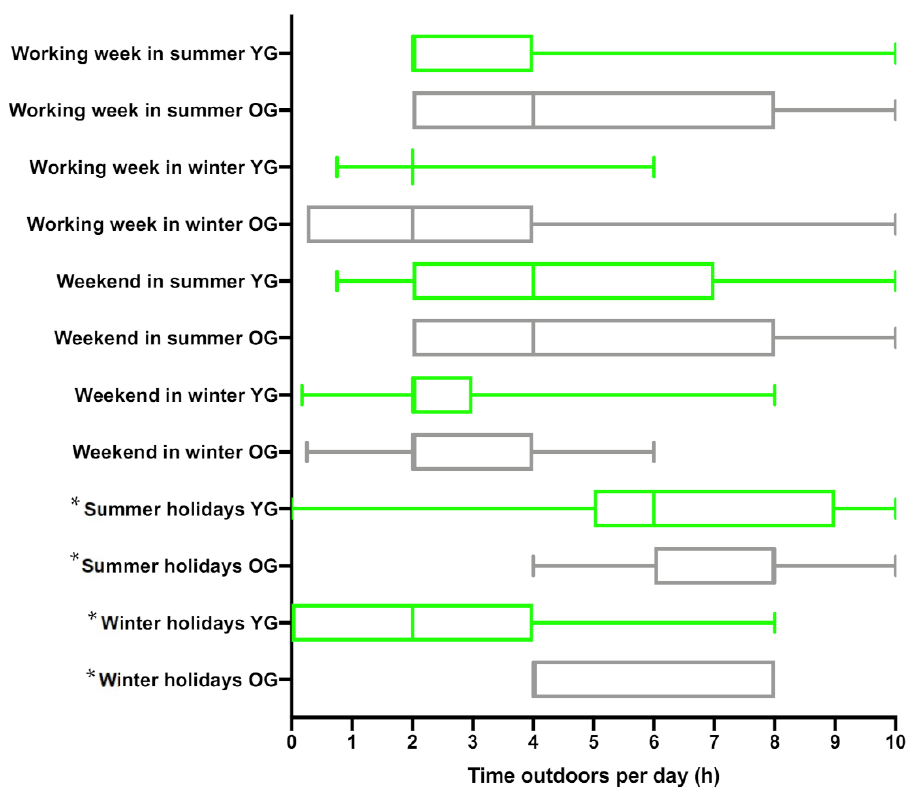
Figure 2. Time spent outdoors in younger (YG) and older (OG) groups of volunteers during the working week in summer and winter at home in the UK, weekend in summer at home in the UK, summer and winter holidays. Plot shows range (whiskers), median (thick lines) and lower and upper quartiles (boxes) of number of hours spent outdoors per day. * The length of the holiday was given a value of zero (0) if volunteers reported not going on